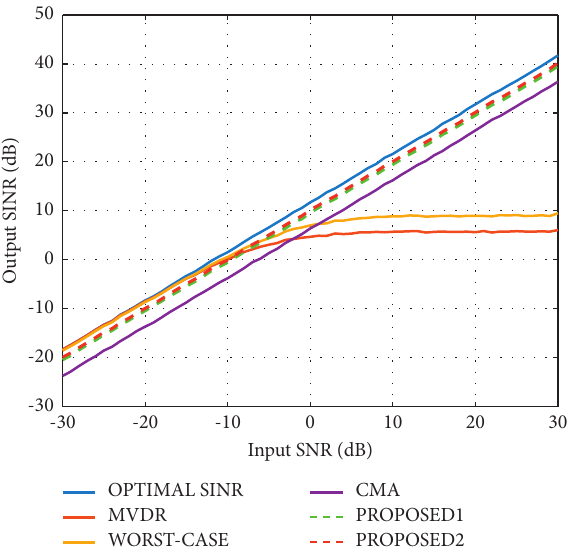
Figure 4: MRA: output SINR versus the input SNR.